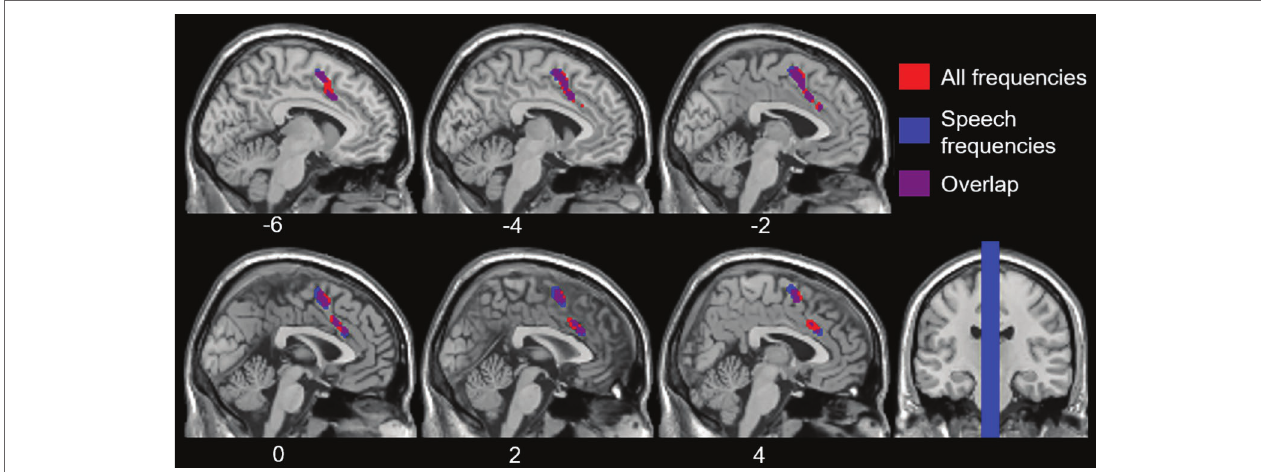
FIGURE 3 | Voxels with functional connectivity to right Heschl’s gyrus that are significant and positively correlated with average hearing thresholds across all frequencies (red) and within speech frequencies (0.5–2 kHz, blue), controlling for age, WMI, and PSI voxelwise p < 0.001 uncorrected, cluster-level p < 0.05 FDR.